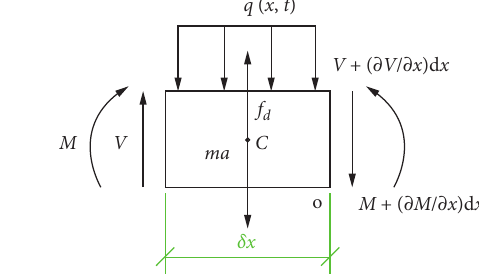
Figure 2: Infinitesimal segment